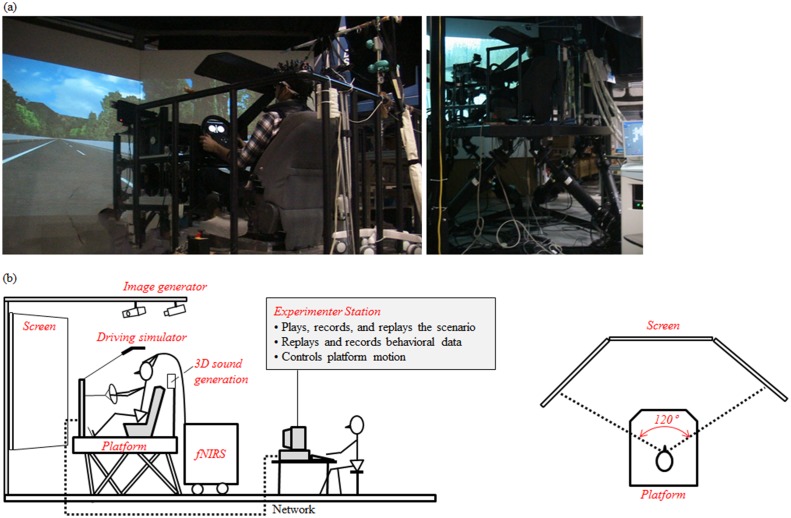
Driving simulator system.(a) Photos of the experimental landscape and setup. (b) Schematic views of the experimental setup.